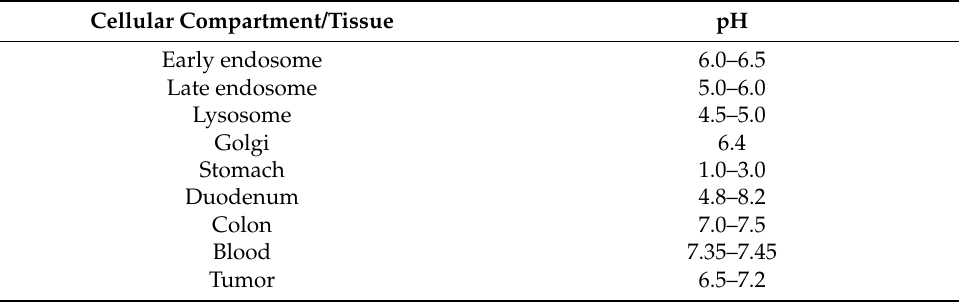
Table 5. pH Associated with Different Cellular Compartments and Tissues (Adopted from